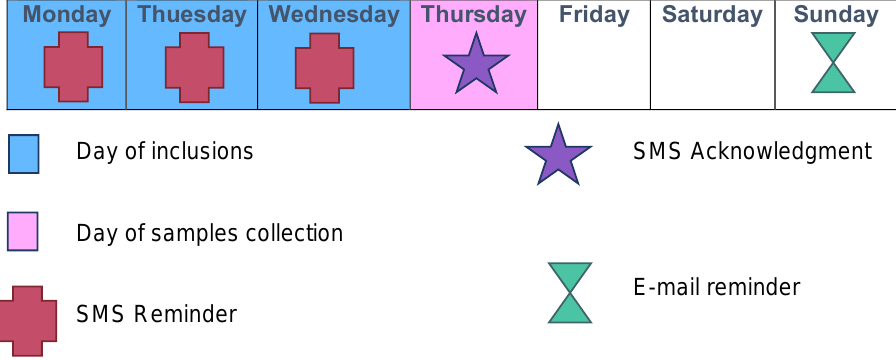
Figure 3. Typical inclusion week during ECOVIR’s project.